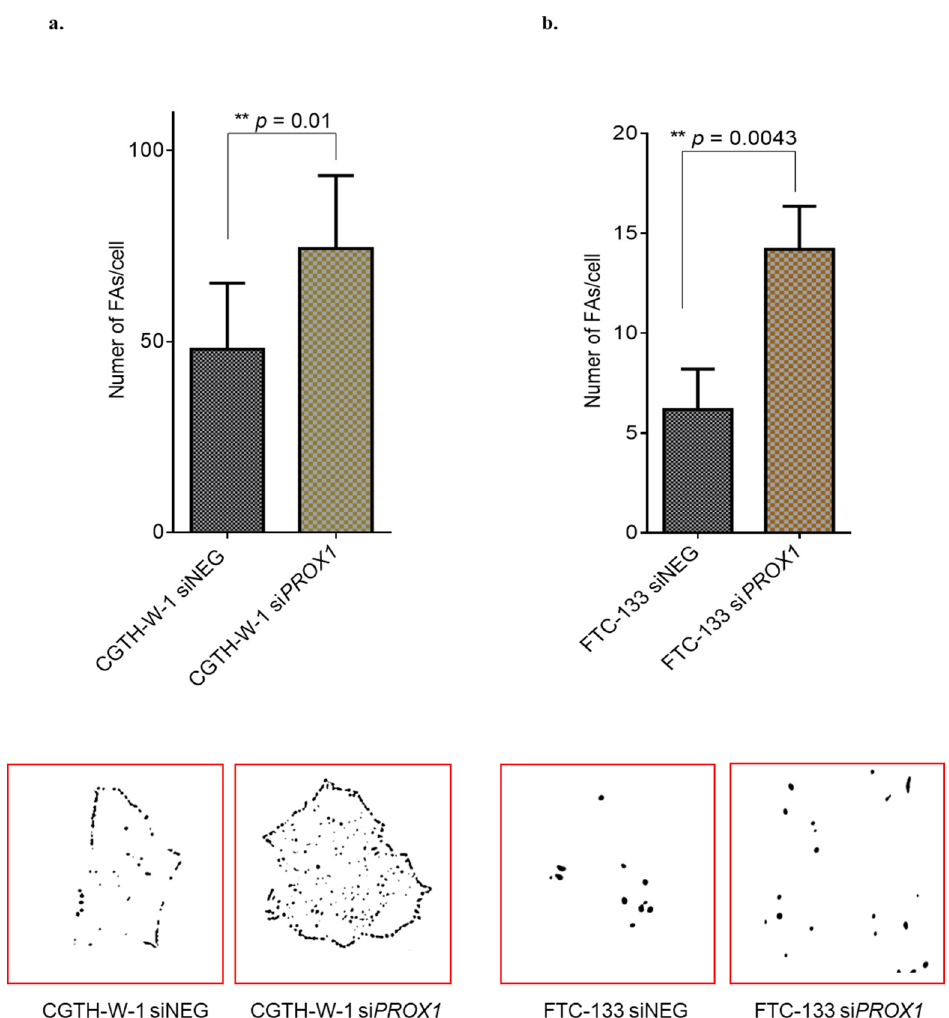
Figure 3. The number of focal adhesions (FAs) increases after silencing of PROX1 in CGTH-W-1 and FTC-133 cells. FAs were measured using Log3D plugin and CLAHE plugin (ImageJ) according to the described protocol [28]. ( a , b ) The number of FAs was significantly higher in cells-si PROX1 compared to cells-siNEG. Representative images of FAs that were obtained using ImageJ are included below the graph.